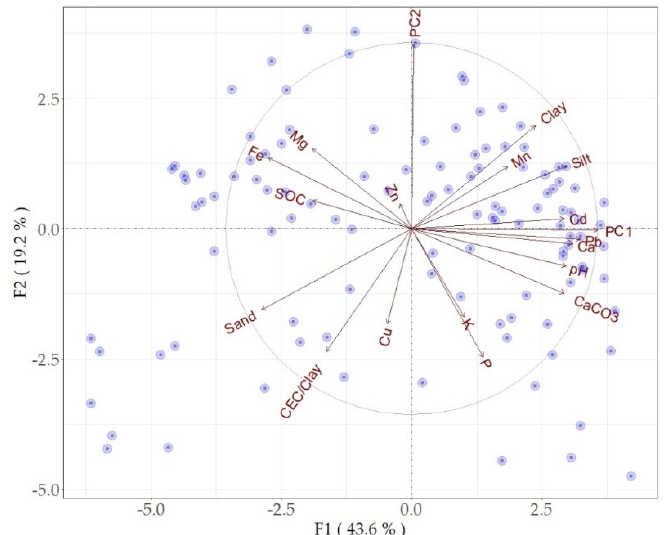
Figure 4. Biplot of PCA factors 1 and 2, based on soil properties and the first two principal compo- nents (PC1 and PC2) of the spectral reflectance data. (PC1 and PC2) of the spectral reflectance